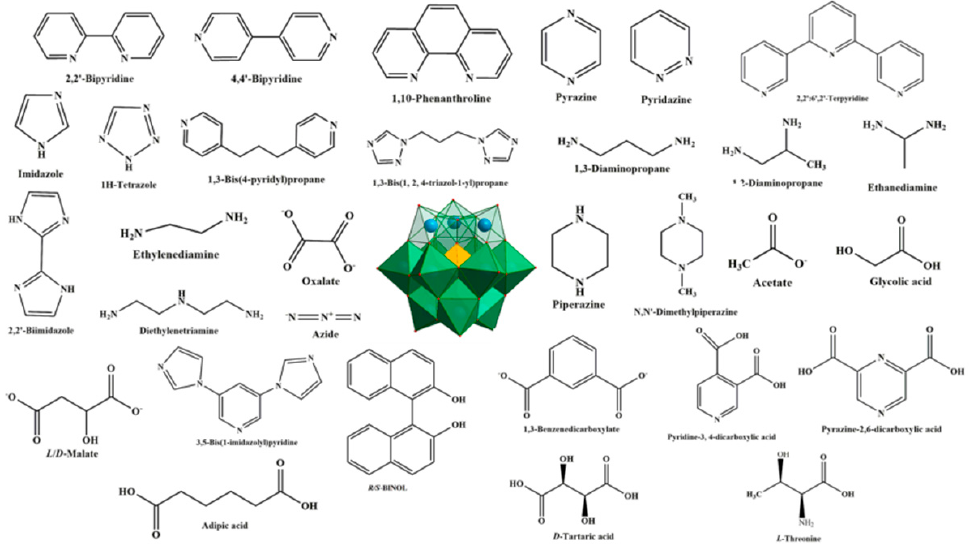
Figure 1. Some organic ligands employed to inorganic–organic hybrids based on lacunary Keggin-type polyoxometalates in the literature.